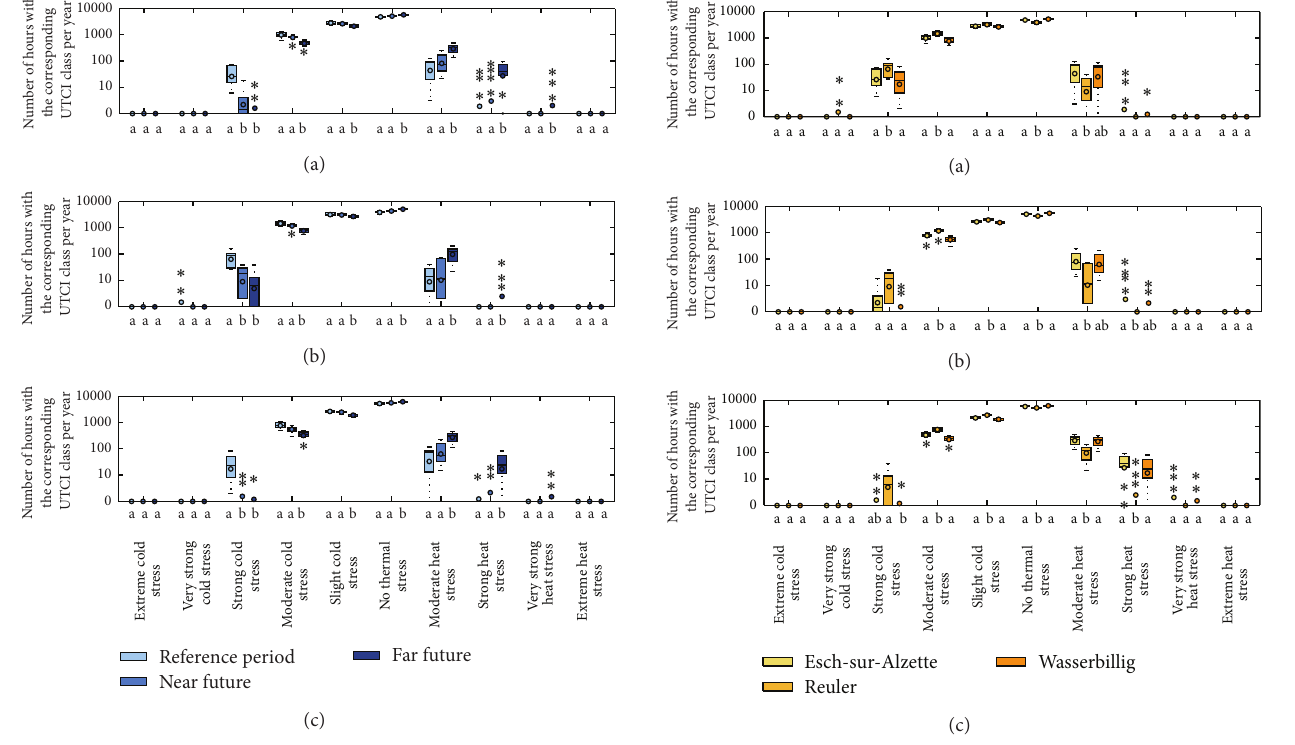
Figure 8: Boxplots of UTCI values for the three pseudo stations Esch-sur-Alzette, Reuler, and Wasserbillig separated by the three periods: reference period 1991–2000 (a), near future 2041–2050 (b), and far future 2091–2100 (c). Boxplots show the number of hours within the corresponding UTCI class per year. The whisker length is determined by 1.5 ∗ interquartile range (IQR). All values larger than 1.5 ∗ IQR are treated as outliers. Median values are indicated by the line inside the box; mean values are highlighted by the dot. Groups that are sharing the same letters are not significantly different ( 𝑃 < 0.05